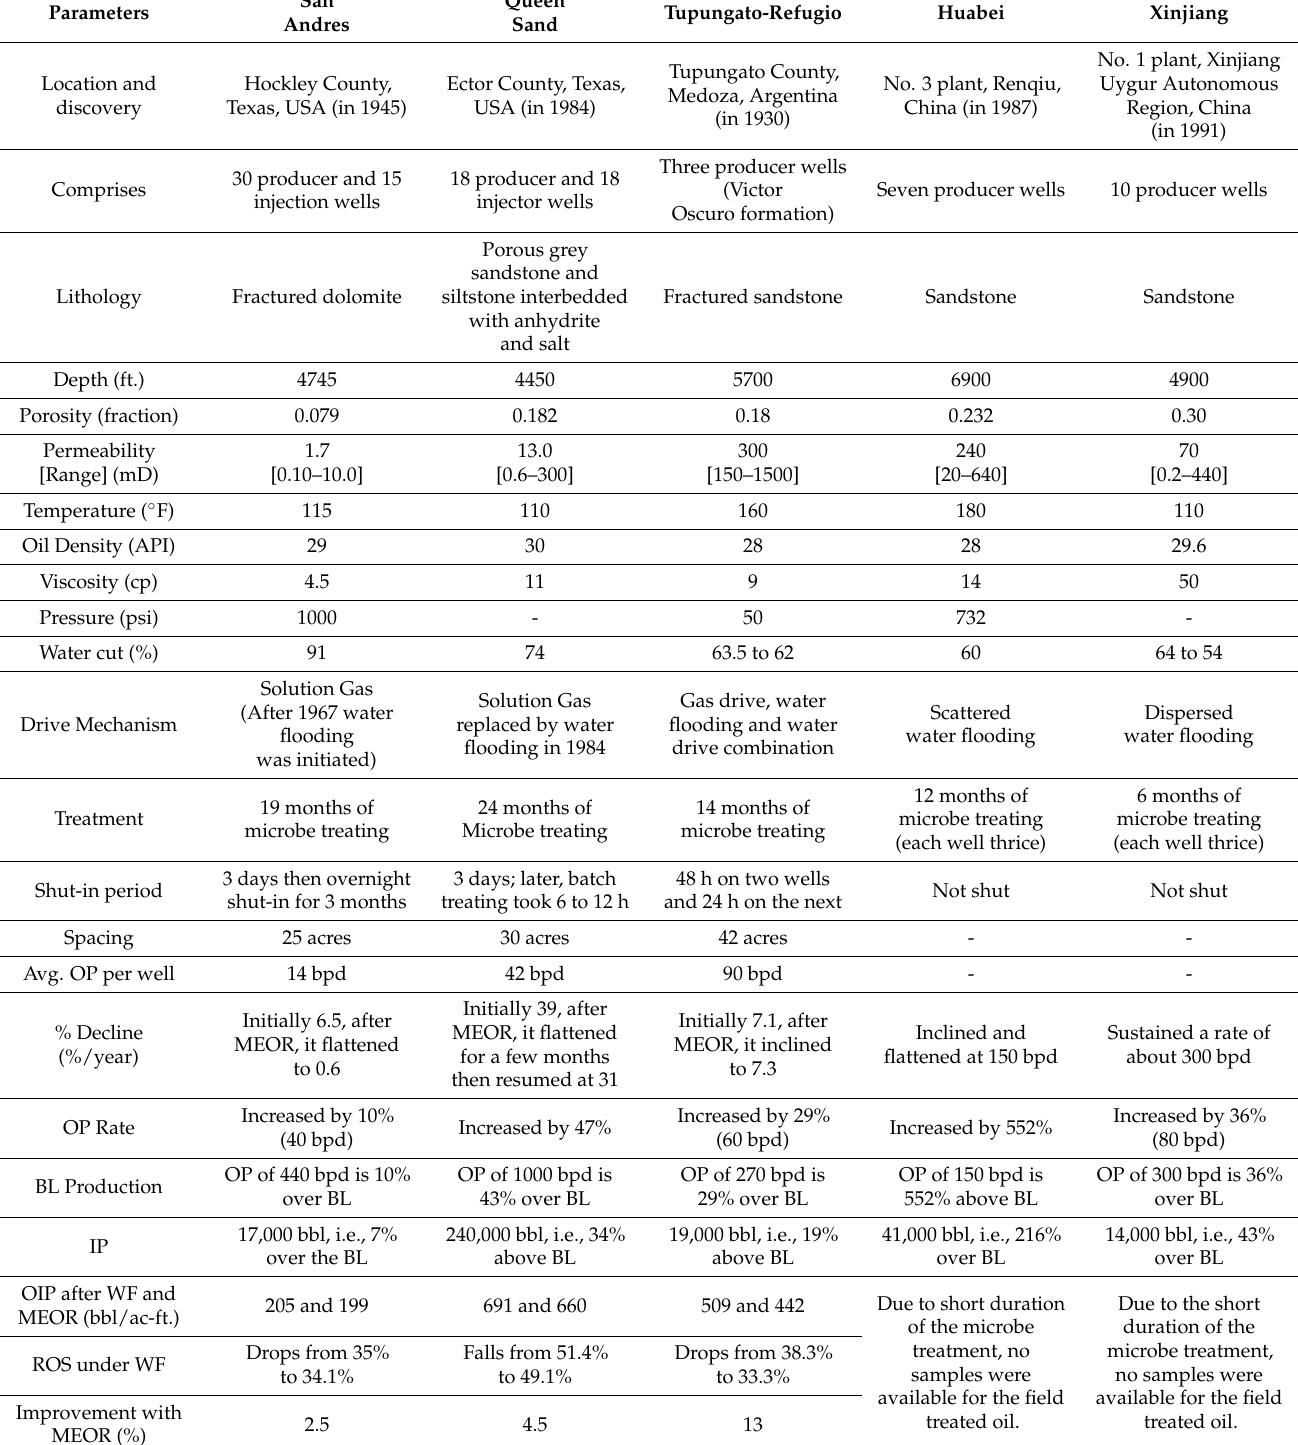
Table 3. Comparison of different project characteristics based on their screening parameters and oil production